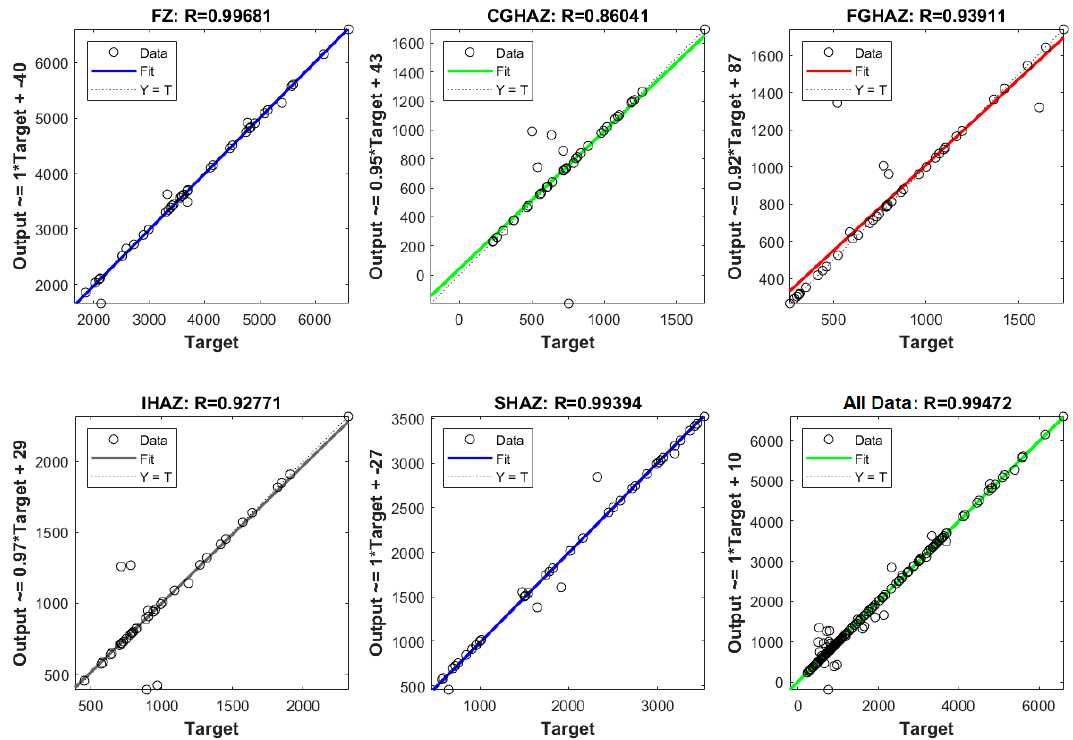
Figure 13. Comparison of linear regressions of targets by variable relative to outputs in model F.